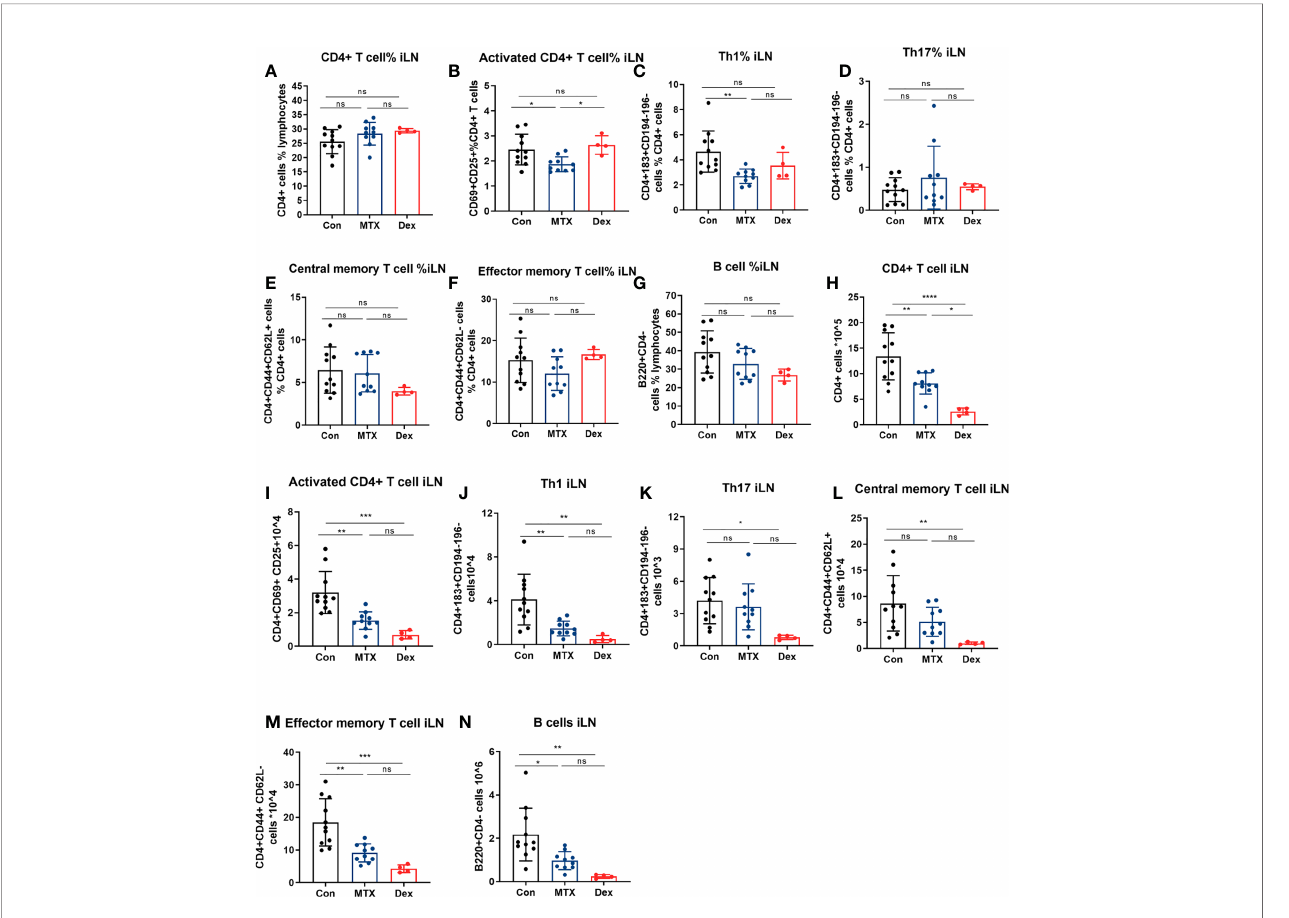
FIGURE 8 | Differential effects of MTX and DEX on levels of DTHA-induced immune cells. Cell suspensions were prepared from the draining iLN of DTHA mice treated without or with MTX or DEX on day 9. CD4+ T cell, activated CD4+ T cell, Th1, Th17, central/effector memory T cell, and B cell were analyzed by fl ow cytometry. The proportion and absolute number of CD4+ T cell (A, H) , activated CD4+ T cell (B, I) , Th1 (C, J) , Th17 (D, K) , central memory CD4+ T cell (E, L) , effector memory CD4+ T cell (F, M) and B cell (G, N) in iLN from mice in given groups are shown.. All data are presented as mean ± SD. The DEX group data is from one experiment. All other data are pooled from two independent experiments with three to six mice in each group per experiment. Statistical signi fi cance was calculated by ANOVA with Tukey multiple comparison test (*p < 0.05, **p < 0.01, ***p < 0.001, ****p < 0.0001, ns: p > 0.05). Con, DTHA Control